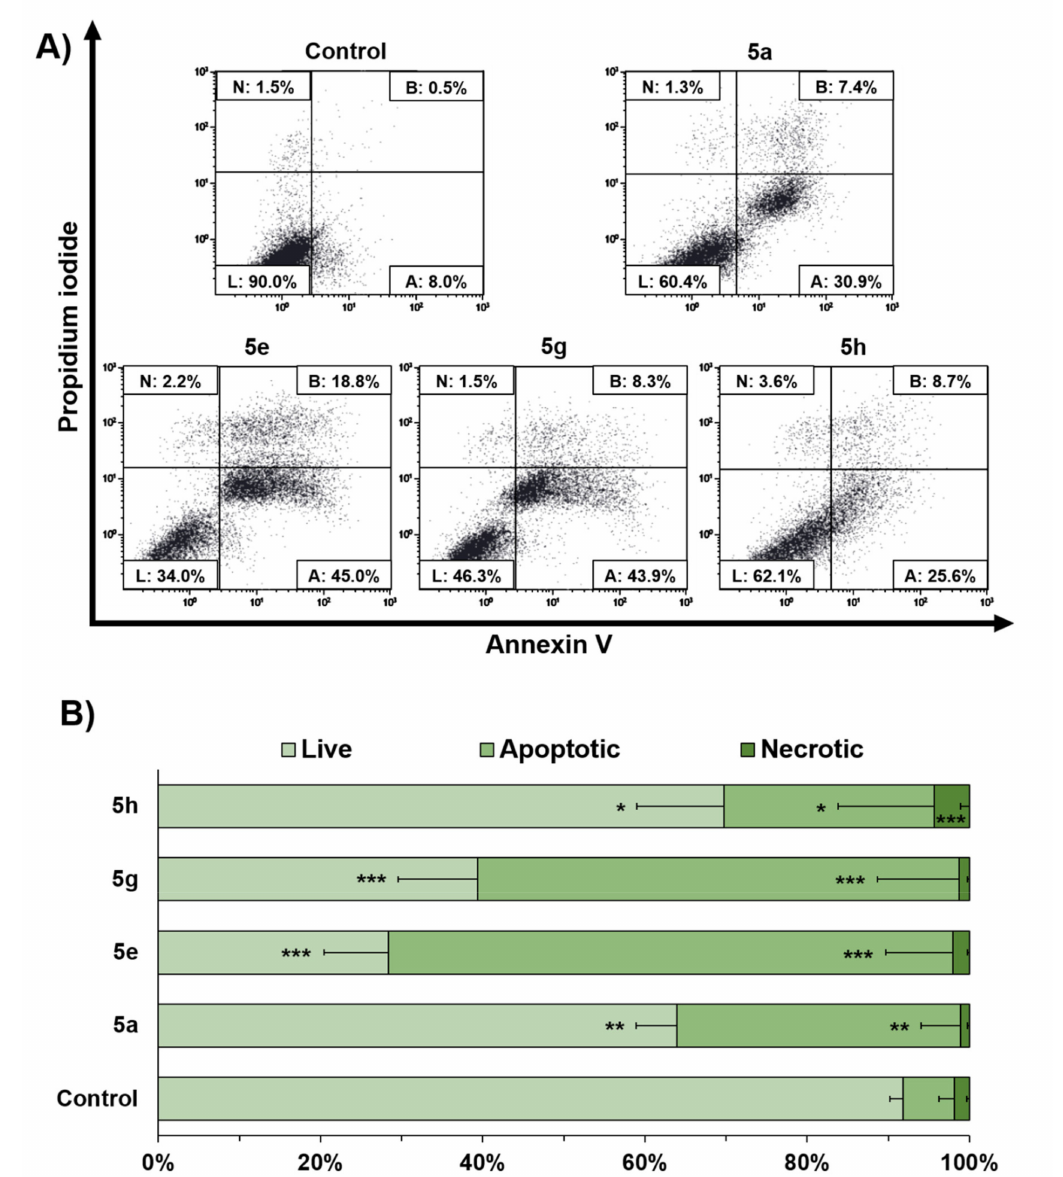
Figure 3. Flow cytometric detection of apoptosis and necrosis with Annexin-V-fluorescein isothiocyanate (FITC) and propidium iodide staining in MCF-7 cells after 24 h exposure to 0.5% DMSO vehicle (control) and IC 50 concentrations of the selected derivatives 5a , 5e , 5g , and 5h . ( A ) Dot plots show a single representative experiment. Abbreviations: L, live cells; A, early apoptotic cells; B, late apoptotic cells; N, necrotic cells. ( B ) Relative amount of live, necrotic, and apoptotic cells after 24 h incubation with IC 50 concentrations of 5a , 5e , 5g , and 5h and 0.5% DMSO vehicle (control). Percent of apoptotic cells was obtained from the sum of early and late apoptosis. Data are presented as mean ± SD; n = 3. Statistical significances are referred to the DMSO control. Differences between groups were determined by analysis of variance (ANOVA), and Dunnett’s test was used for multiple comparisons with the control. * p < 0.05; ** p < 0.01; *** p <